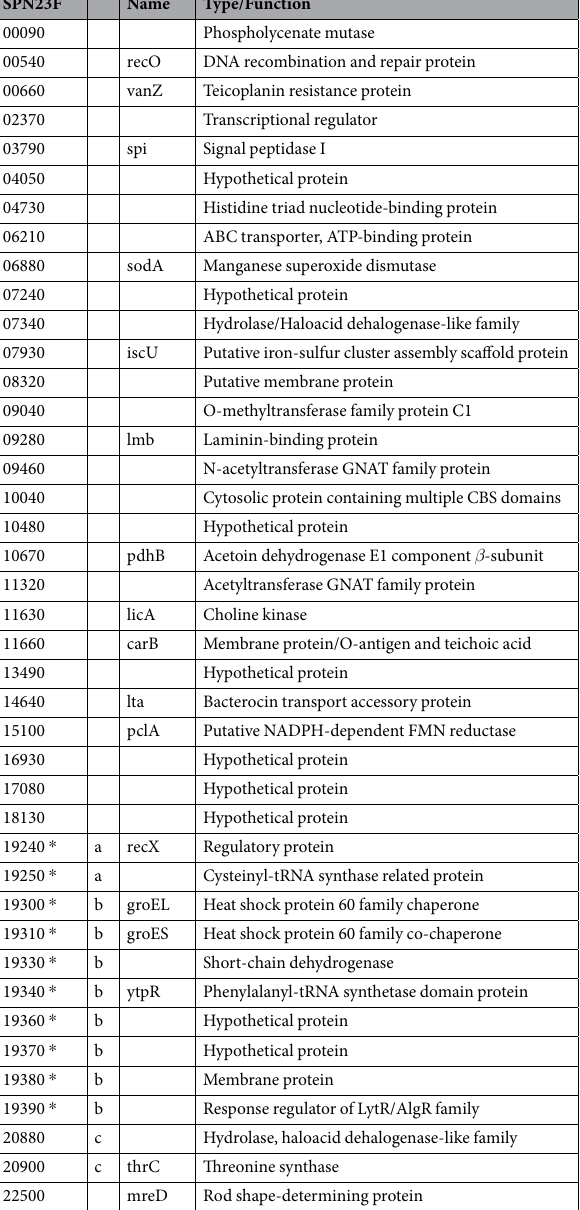
Rod shape-determining protein Table 2. Top genes for Sequence Cluster prediction. Genes marked with * flank up to 10 genes, upstream or downstream from the groESL operon. Letters a to c denote groups of contiguous genes (minimum proximity of 2